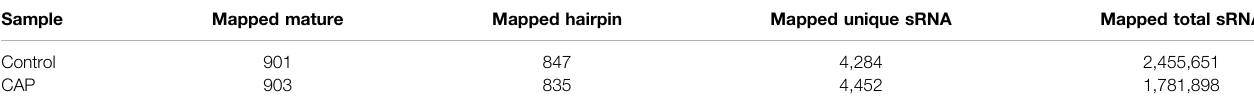
TABLE 3 | Known miRNAs obtained Sample